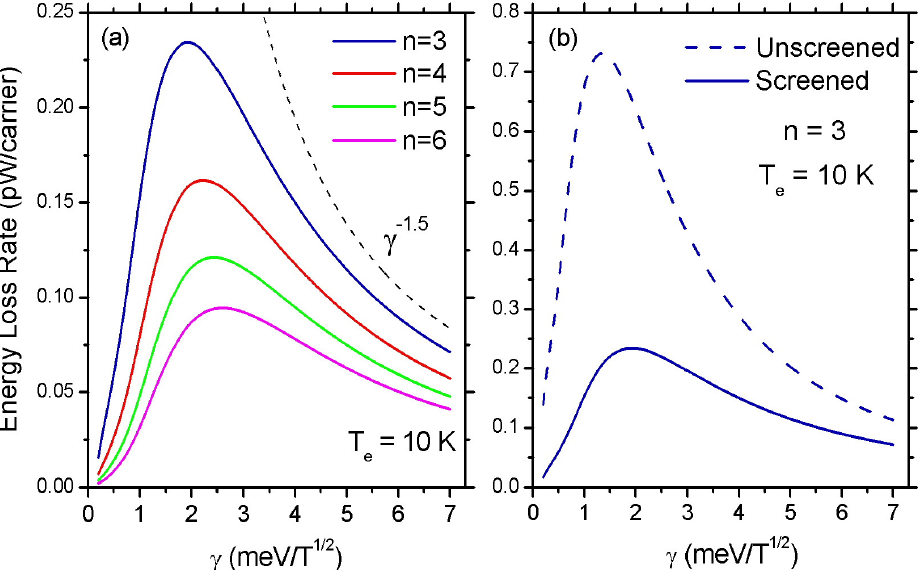
Figure 6. The energy loss rate as a function of γ in an MLG with n s = 10 16 m − 2 at T e = 10 K. In ( a ), the ELR peak values are depicted as a function of the LL broadening parameter when the 3rd, 4th, 5th, and 6th LL is occupied. The black dashed line follows a γ − 1.5 law. In ( b ), the effect of screening on the ELR is shown as γ increases.